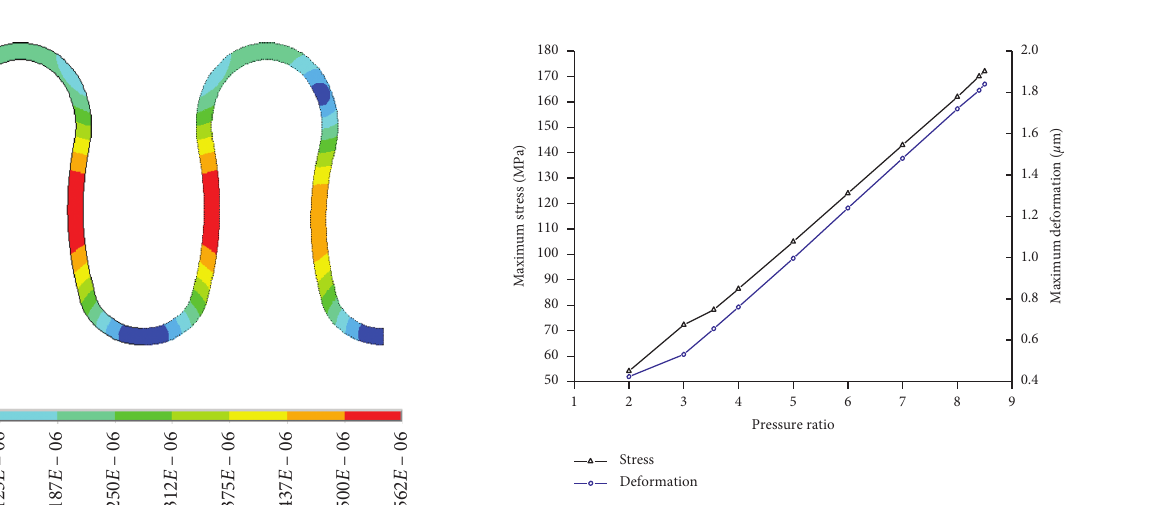
Figure 15: Variation of maximum stress and maximum defor- mation with pressure ratio in